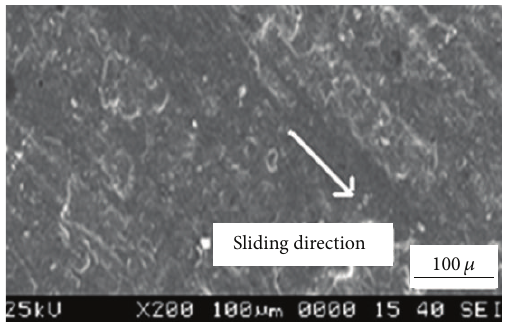
Figure 13: SEM micrograph of the worn surface of the Al-7.5wt.% Gr composite at a normal load of 49N with 2 m/s sliding velocity.